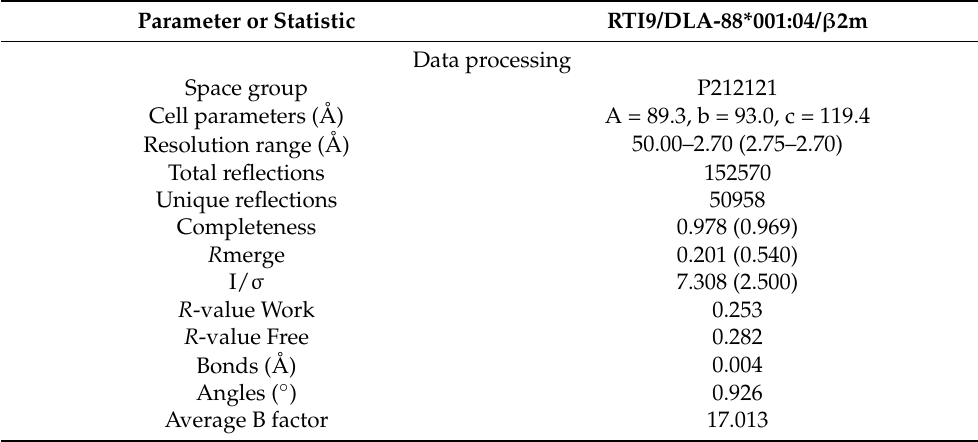
Table 1. X-ray data diffraction data processing and refinement statistics.